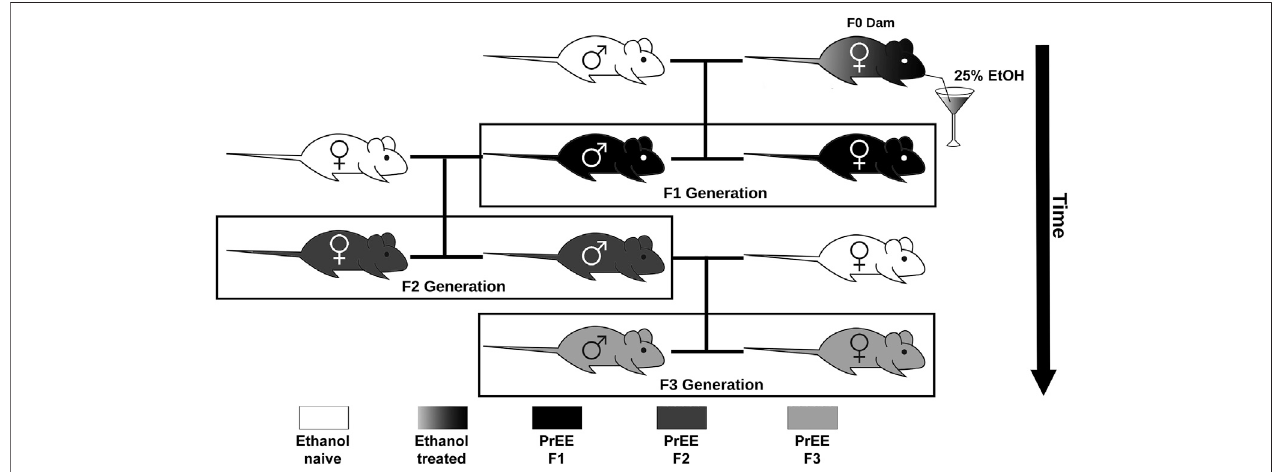
FIGURE 1 | Transgenerational FASD model breeding paradigm. Initially, ethanol (EtOH) nai € ve P90 CD-1 mice were paired for breeding. Upon con fi rmation of copulation via vaginal plug, dams were given 25% EtOH in water throughout gestation (EtOH treated; gradient) to generate the prenatal EtOH exposed F1 experimental group (PrEE F1; black). Legend to 8 – 10 week old F1 males were then paired with EtOH nai € ve females to generate the PrEE F2 experimental group (dark gray). Lastly, legend to 8 – 10 week old F2 males were then paired with EtOH nai € ve females to generate the PrEE F3 experimental group (light gray).